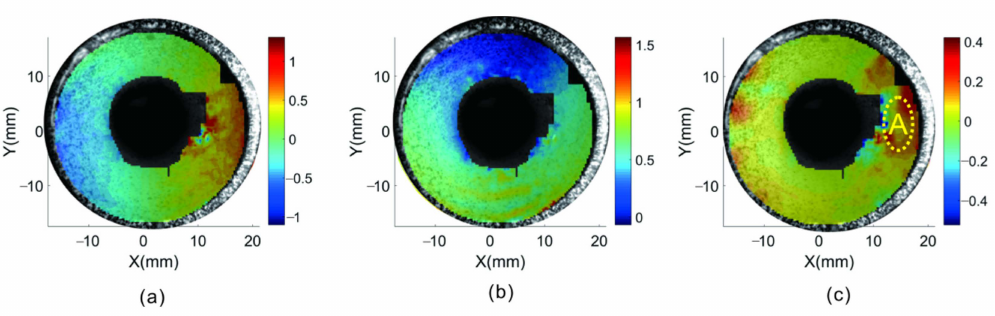
Figure 12. Pipe wall displacement and strain distribution under 10 kN load: ( a ) displacement of u -field; ( b ) displacement of v -field; ( c ) ε xx strain.